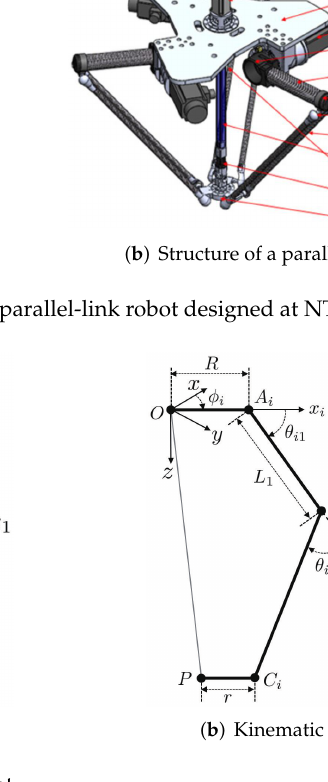
Figure 2. Schematics of the Delta